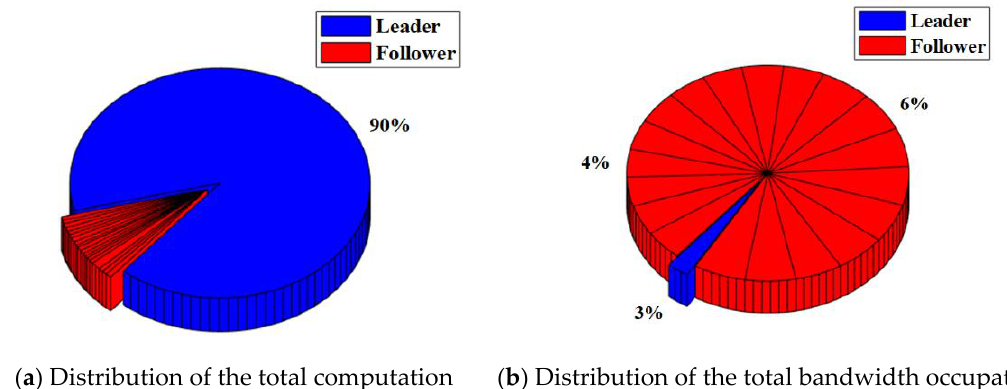
Figure 10. Resource occupation of the algorithm with no malicious nodes.